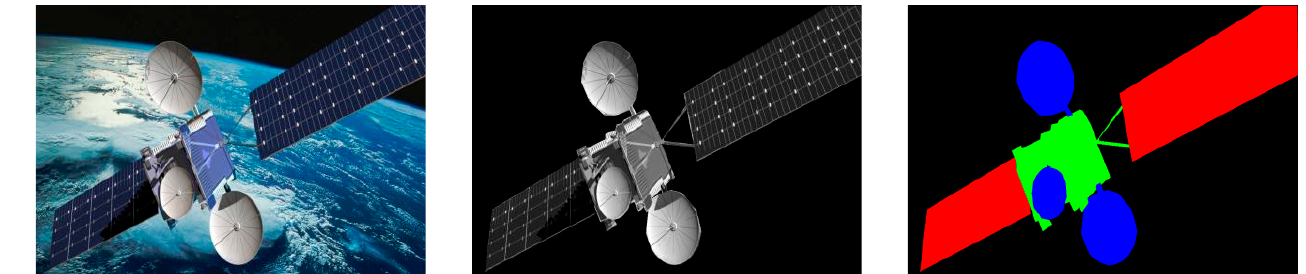
Figure 1. Examples of original, processed, and labeled images in the dataset. Red: solar panels; blue: antennae; green: satellite body.